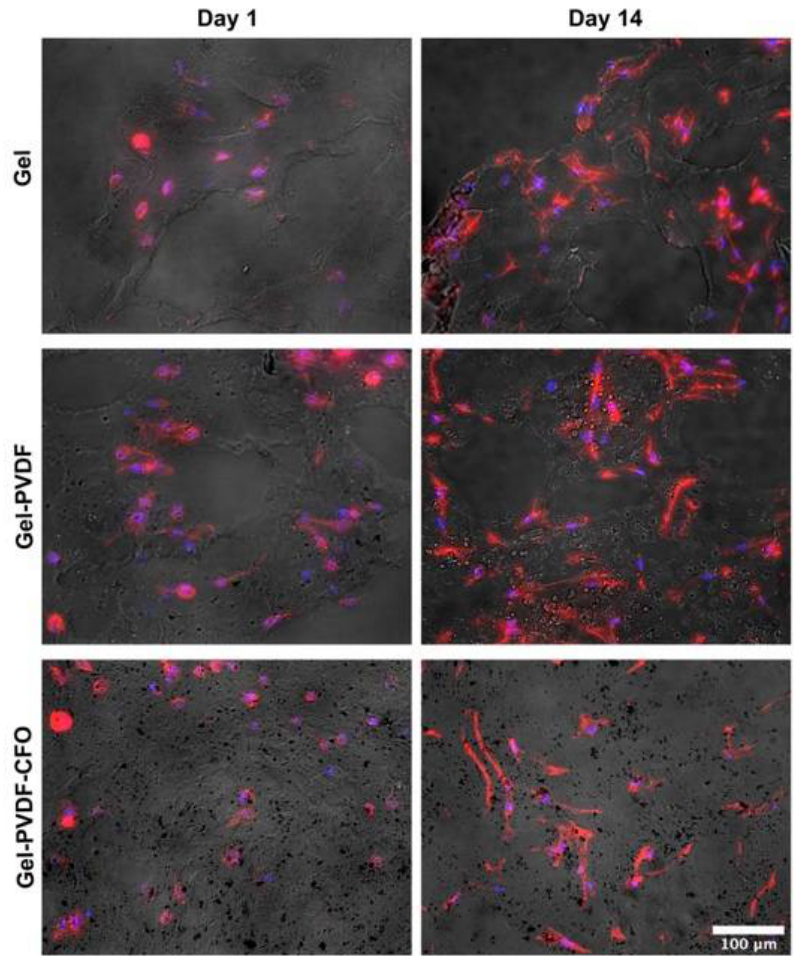
Figure 3. Representative fluorescence images of Gel, Gel-PVDF and Gel-PVDF-CFO cryo-sectioned hydrogels merged with hydrogel brightfield images after 1 and 14 days of static culture. Actin cytoskeleton appears in red and cell nuclei in blue. Scale bar 100 µm.